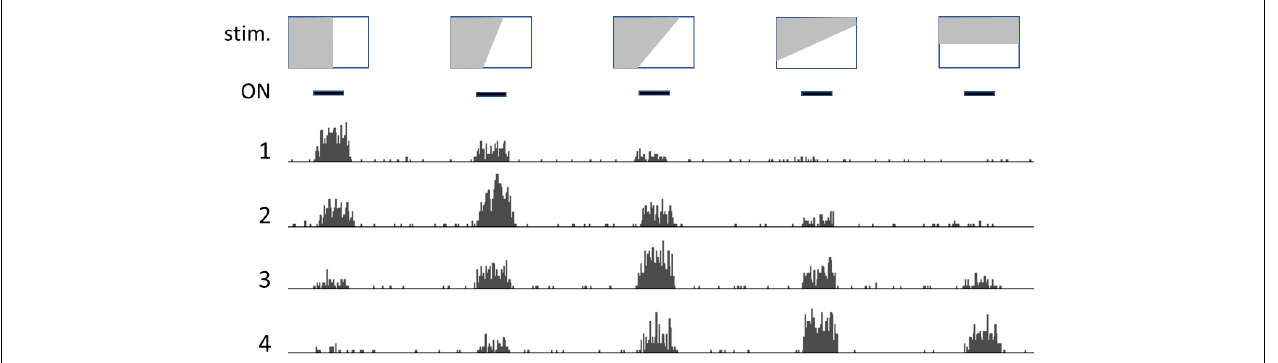
FIGURE 1 | Drawing that illustrates how neurons detect relations (patterns). Depiction of the activity of neighboring neurons in the visual cortex: top row shows representative images, that are presented one after the other at the times indicated by the black bars (ON, second row). Numbers 1 to 4 represent histograms of spike frequencies in recordings from neighboring neurons. Each neuron preferentially responds to a profile with a specific slant angle. However, pattern detection is not crisp and absolute, but rather fuzzy and “tentative.”